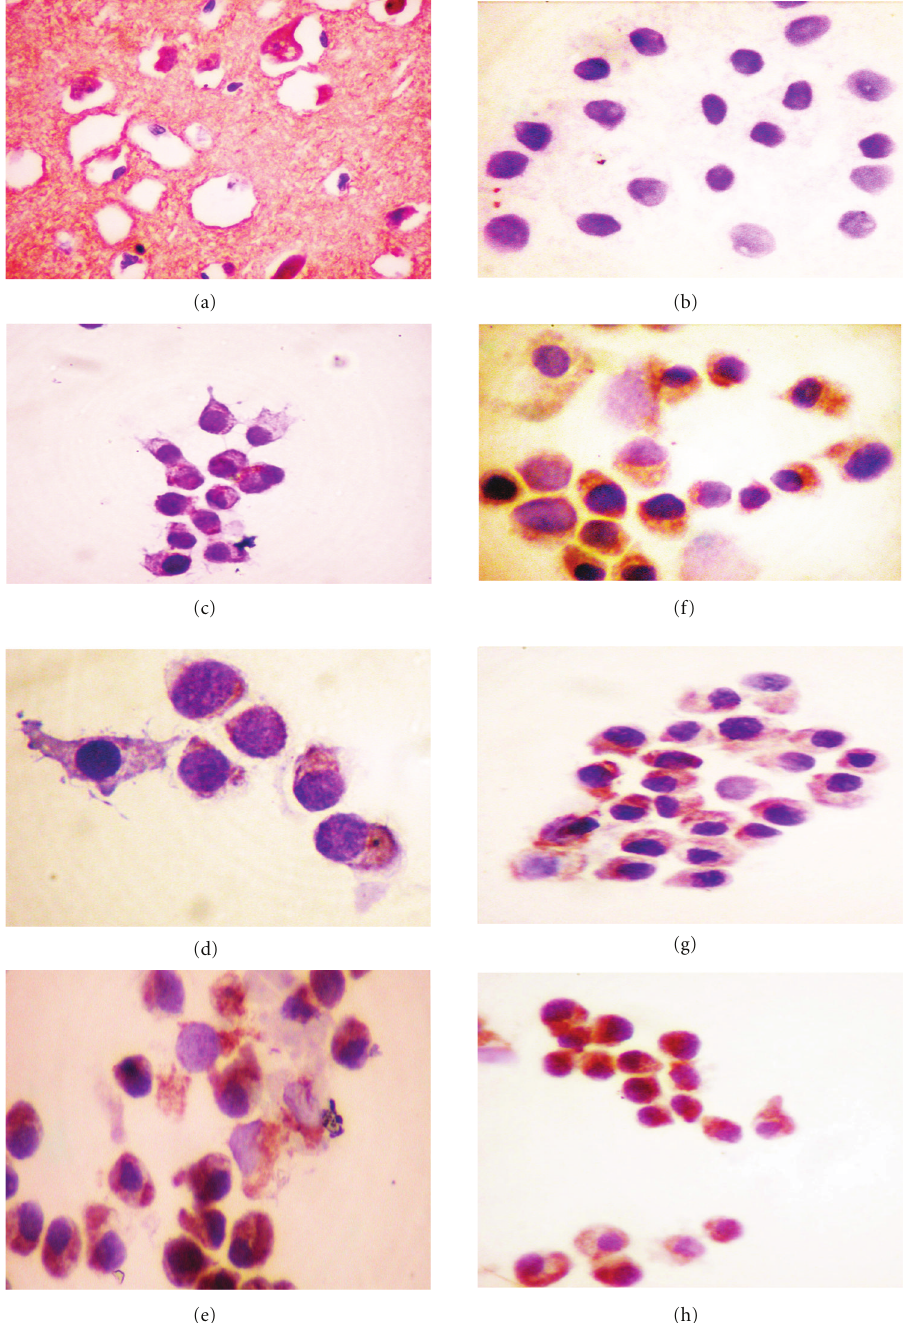
Figure 5: Immunocytochemical staining of MCF-7 cells treated with EOace and EOea at various time periods. Positive control: (a) Human brain tissue, (b)Untreated MCF-7 cells, (c) EOace treated MCF-7 cells at 24 hours, (d) 48 hours and (e) 72 hours. (f) EOea treated MCF-7 cells at 24 hours, (g) 48 hours and (h) 72 hours. Positive expression of LC3-A is indicated by the reddish brown staining.